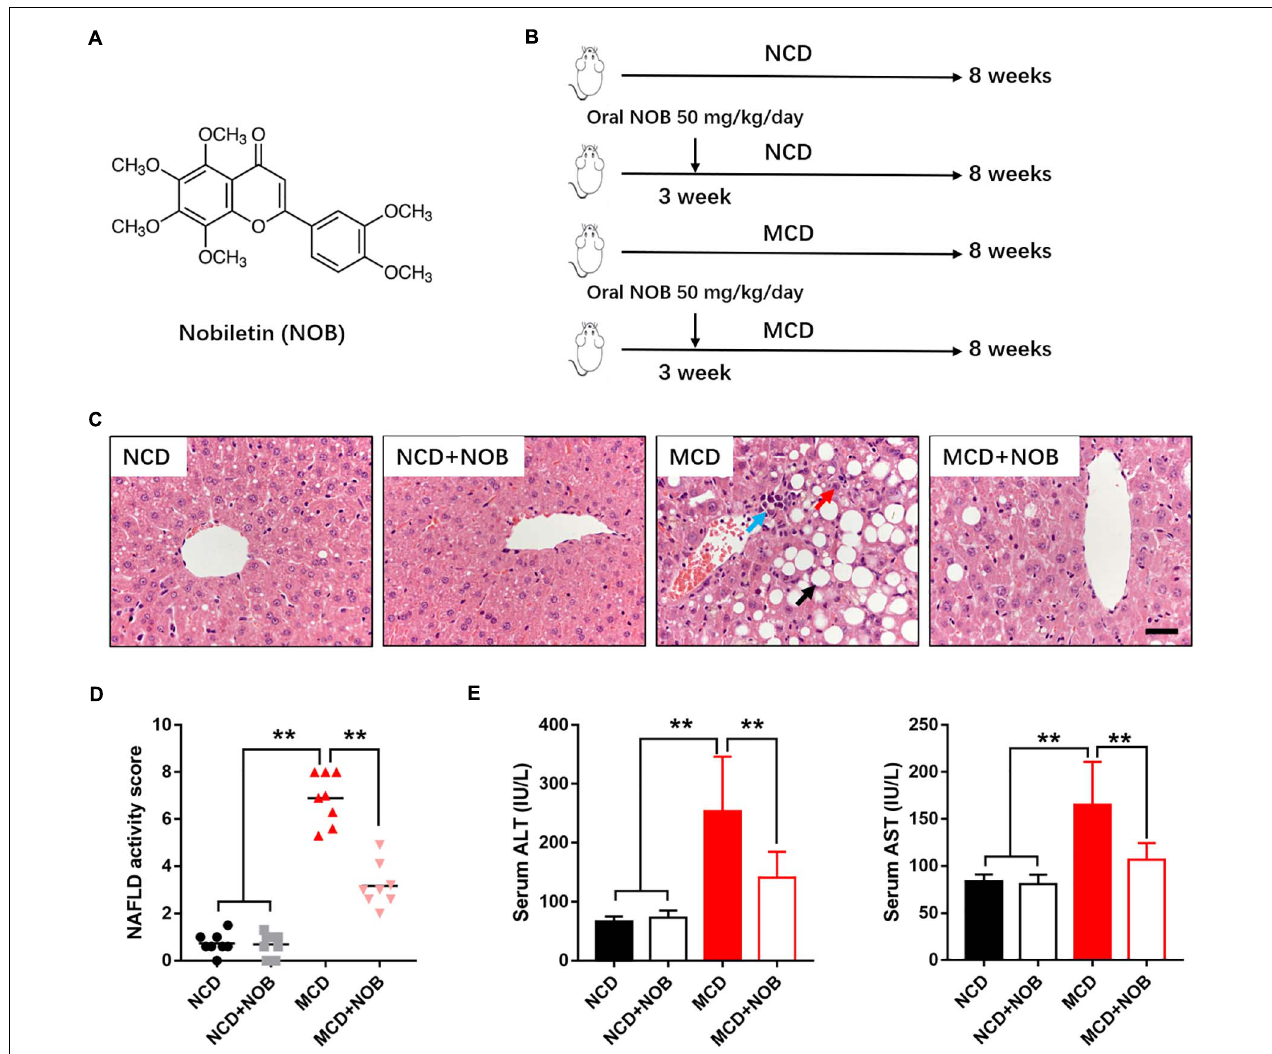
FIGURE 1 | NOB ameliorates liver function in MCD fed mice. (A) The chemical structure of NOB. Its molecular weight is 402.39. (B) The schematic diagram for MCD-induced NASH and NOB administration. C57BL/6 mice were fed either a chow diet as normal control (NCD) or the MCD diet for 8 weeks to induce NASH (MCD). Mice were treated with daily oral doses of NOB (50 mg/kg) from the third week of MCD diet feeding. Water was gavaged as control. (C) The representative images of H&E staining in livers from each group. Scale bar = 300 µ m. Black arrow denotes macrovesicular steatosis; red arrow denotes hepatocellular ballooning; blue arrow denotes lobular inflammation. (D) The NAFLD activity score was shown. (E) Serum alanine aminotransferase (ALT) and aspartate aminotransferase (AST) levels from each group. Data were expressed as the mean ± SD ( n = 8). ** P <